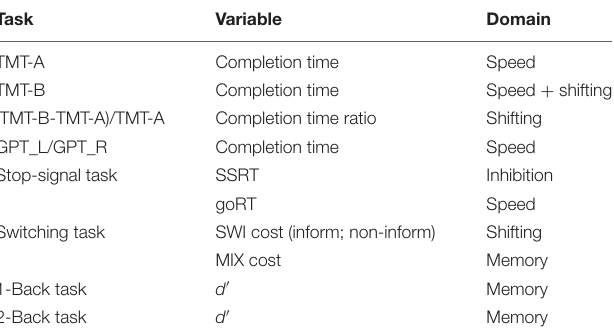
TABLE 2 | Summary of the cognitive tasks’ performance indexes ( Z scores) of cognitive